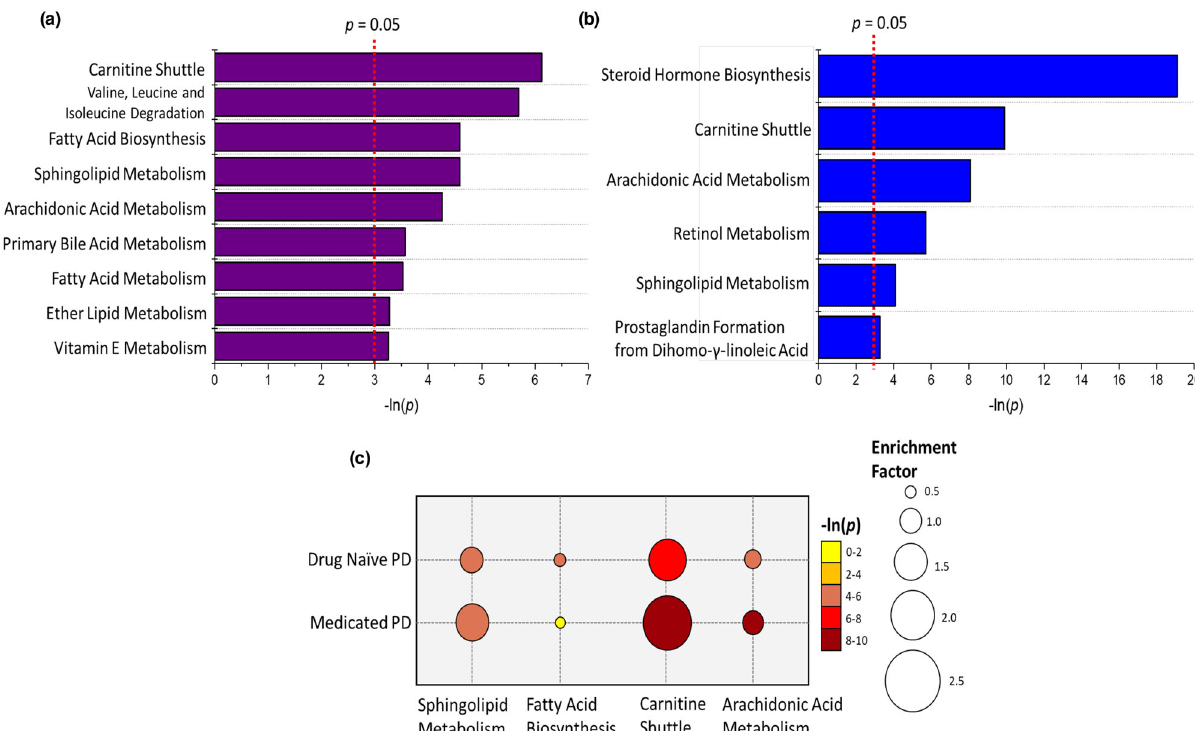
Fig. 4 Results of mummichog analysis for signi fi cant pathways ( p < 0.05). Bar charts report pathways for ( a ) drug naïve PD vs. control and ( b ) medicated PD vs. control. c A bubble chart displaying the common signi fi cant pathways between drug naïve PD and medicated PD compared against controls; the bubble size refers to the enrichment factor of the pathway and the colour represents the natural log of the pathway p